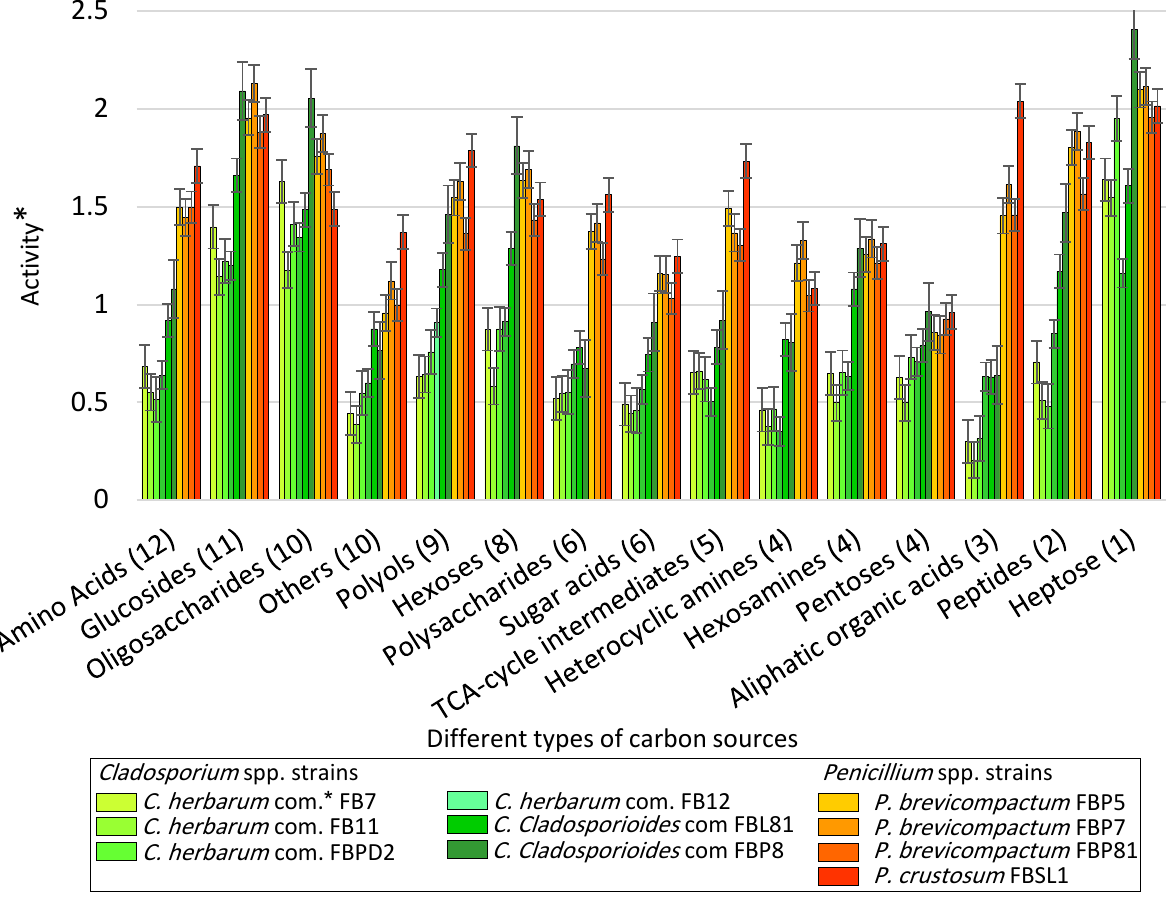
Figure 3. The average utilization rate of 15 classes of carbon sources after 108 h using Cladospo- rium spp. and Penicillium spp. strains inoculated to the commercial FF MicroPlate™ plates (See Figure S1 for more details about carbon sources) based upon the categorization style of Atanasove and Druzhinia [40] (*com. = complex, error bars = standard error) (* = Optical density (OD) of carbon source wells inoculated with strains—OD of the control well at 590